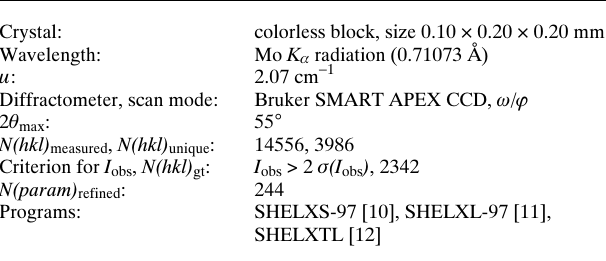
Table 1. Data collection and